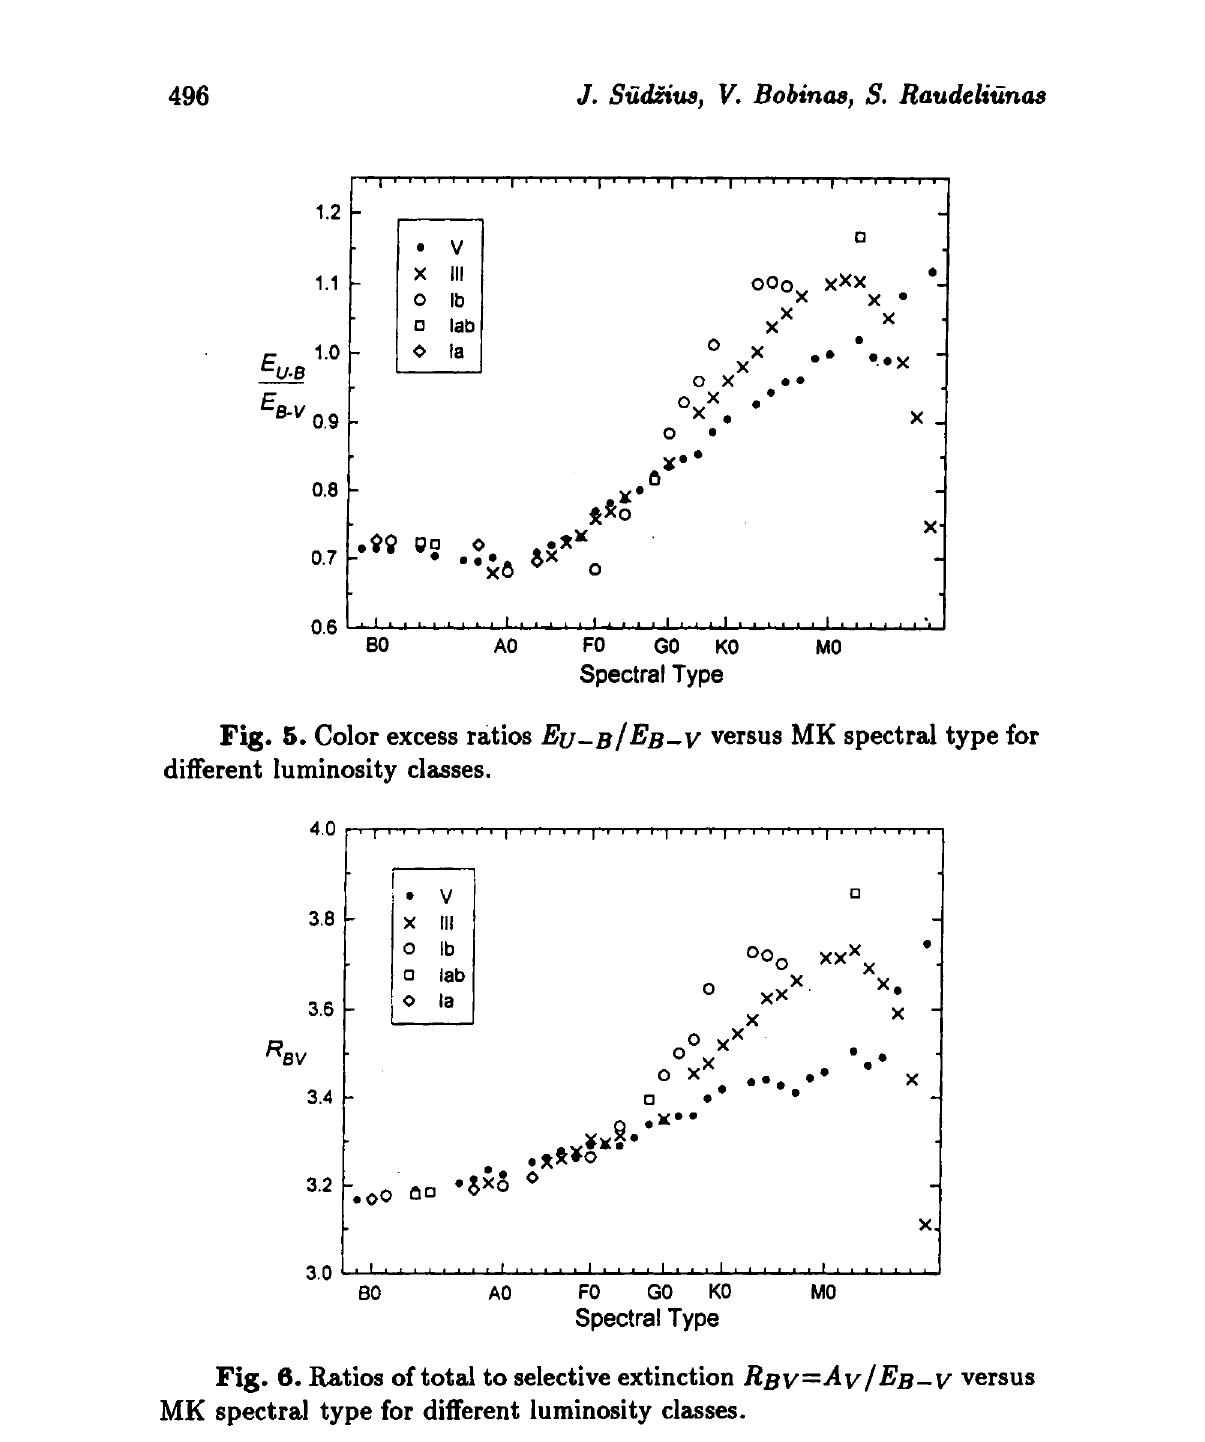
Fig. β. Ratios of total to selective extinction R b v = A v / E b -v versus MK spectral type for different luminosity